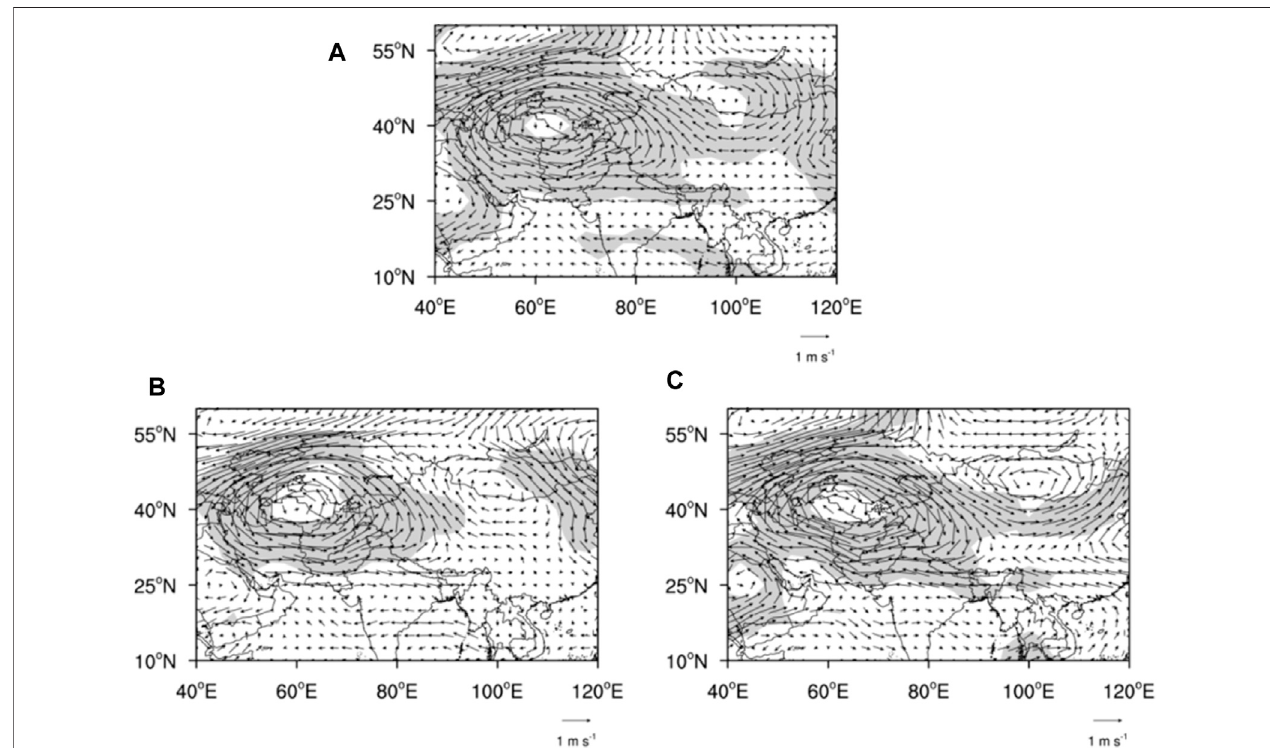
FIGURE 5 | (A) Regression of 500-hPa winds against the CARI during 1971 – 2016, (B) composite distribution of 500-hPa winds anomalies in strong CARI years, (C) as (B) , but in weak CARI years. Shaded regions show signi fi cance at α (cid:2) 0 . 05 level.